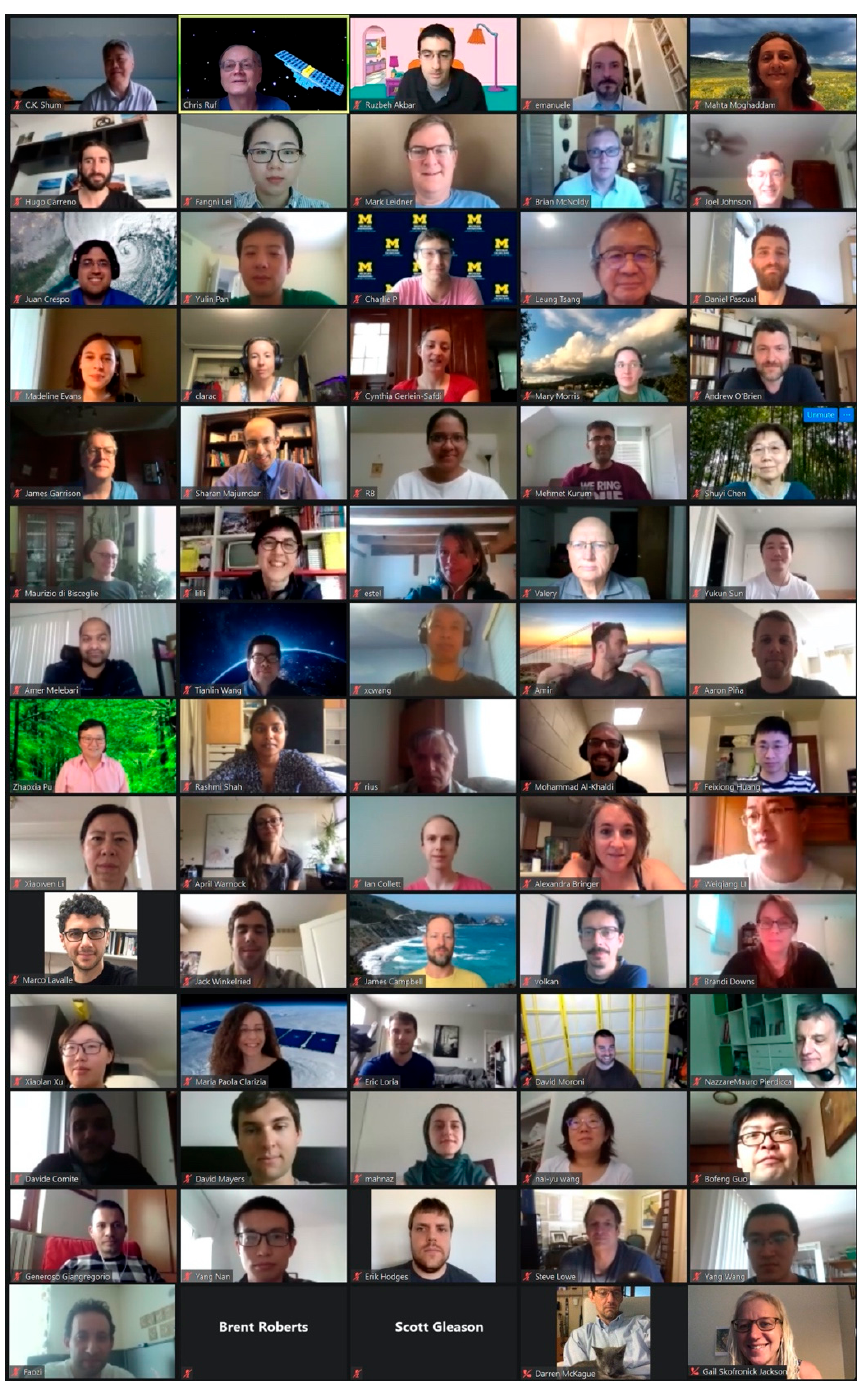
Figure 1. Zoom-derived photo of some Science Team members attending the June 2020 CYGNSS Figure meeting.